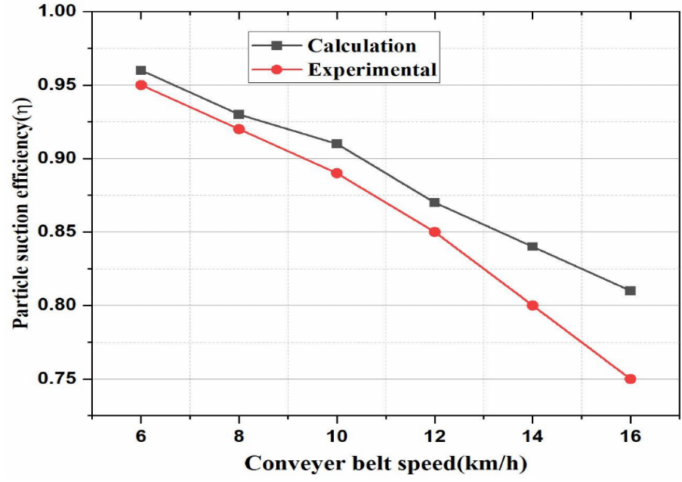
Figure 8. Comparison of the particle suction efficiency on different driving speeds between simulation and experiment.